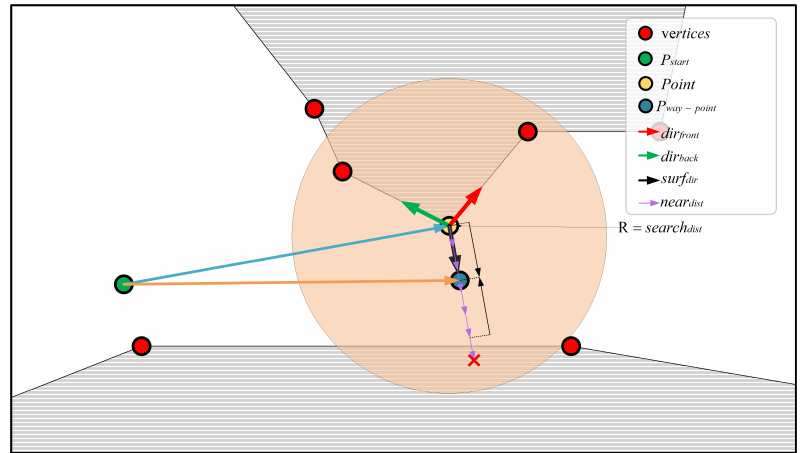
Figure 14. The schematic diagram of generating a way-point. Algorithm 6 Way-point